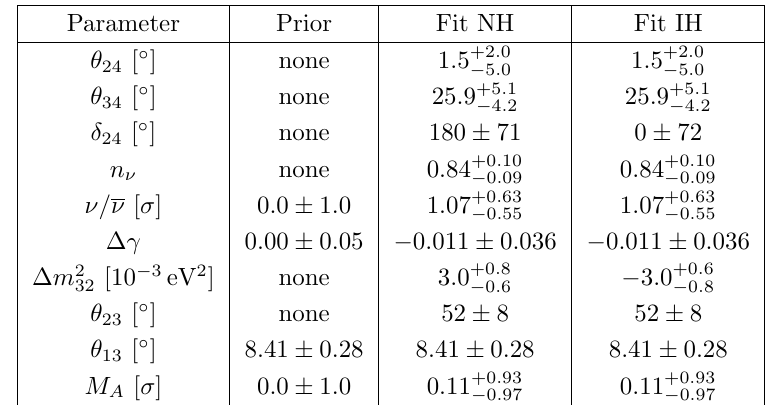
Figure 7 . Contour at 90% CL in the plane of sin 2 (cid:18) 23 and (cid:1) m 2 line) and compared to the results by other experiments: IceCube/DeepCore (red) [31], Super- Kamiokande (green) [39], NO (cid:23) A (purple) [40], T2K (blue) [41], and MINOS (light blue) [42]. The lateral plots show the 1D projections on the plane of the two oscillation parameters under study.